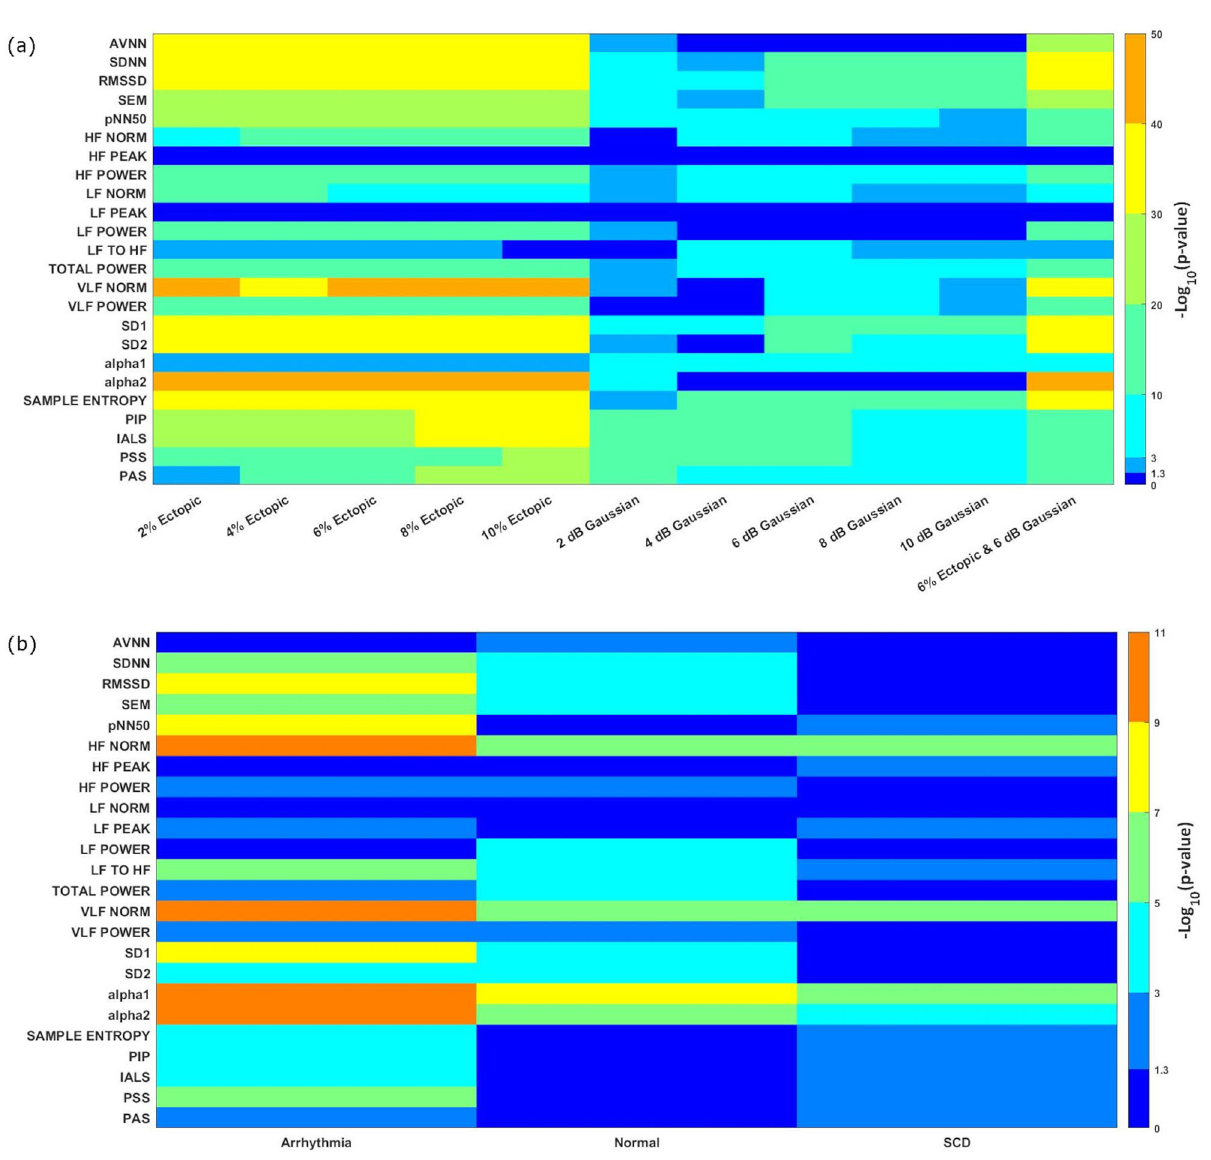
Figure 6. Heat maps for −log 10 transformed p-values for twenty-four of the most common HRV measures for real and artificial signals, ( a ) Heat map of −log 10 (p-value) of original clean and noisy artificial HRV measures for different levels of ectopic and Gaussian noise. The last column shows the artificial HRV measures for both types of noise combined at 6 dB of Gaussian and 6% of ectopic noise, ( b ) Heat map of −log 10 (p-value) of noisy and denoised (by the proposed algorithm) real HRV measures obtained from three Physionet databases: MIT-BIH Arrhythmia, MIT-BIH Normal Sinus Rhythm, and Sudden Cardiac Death